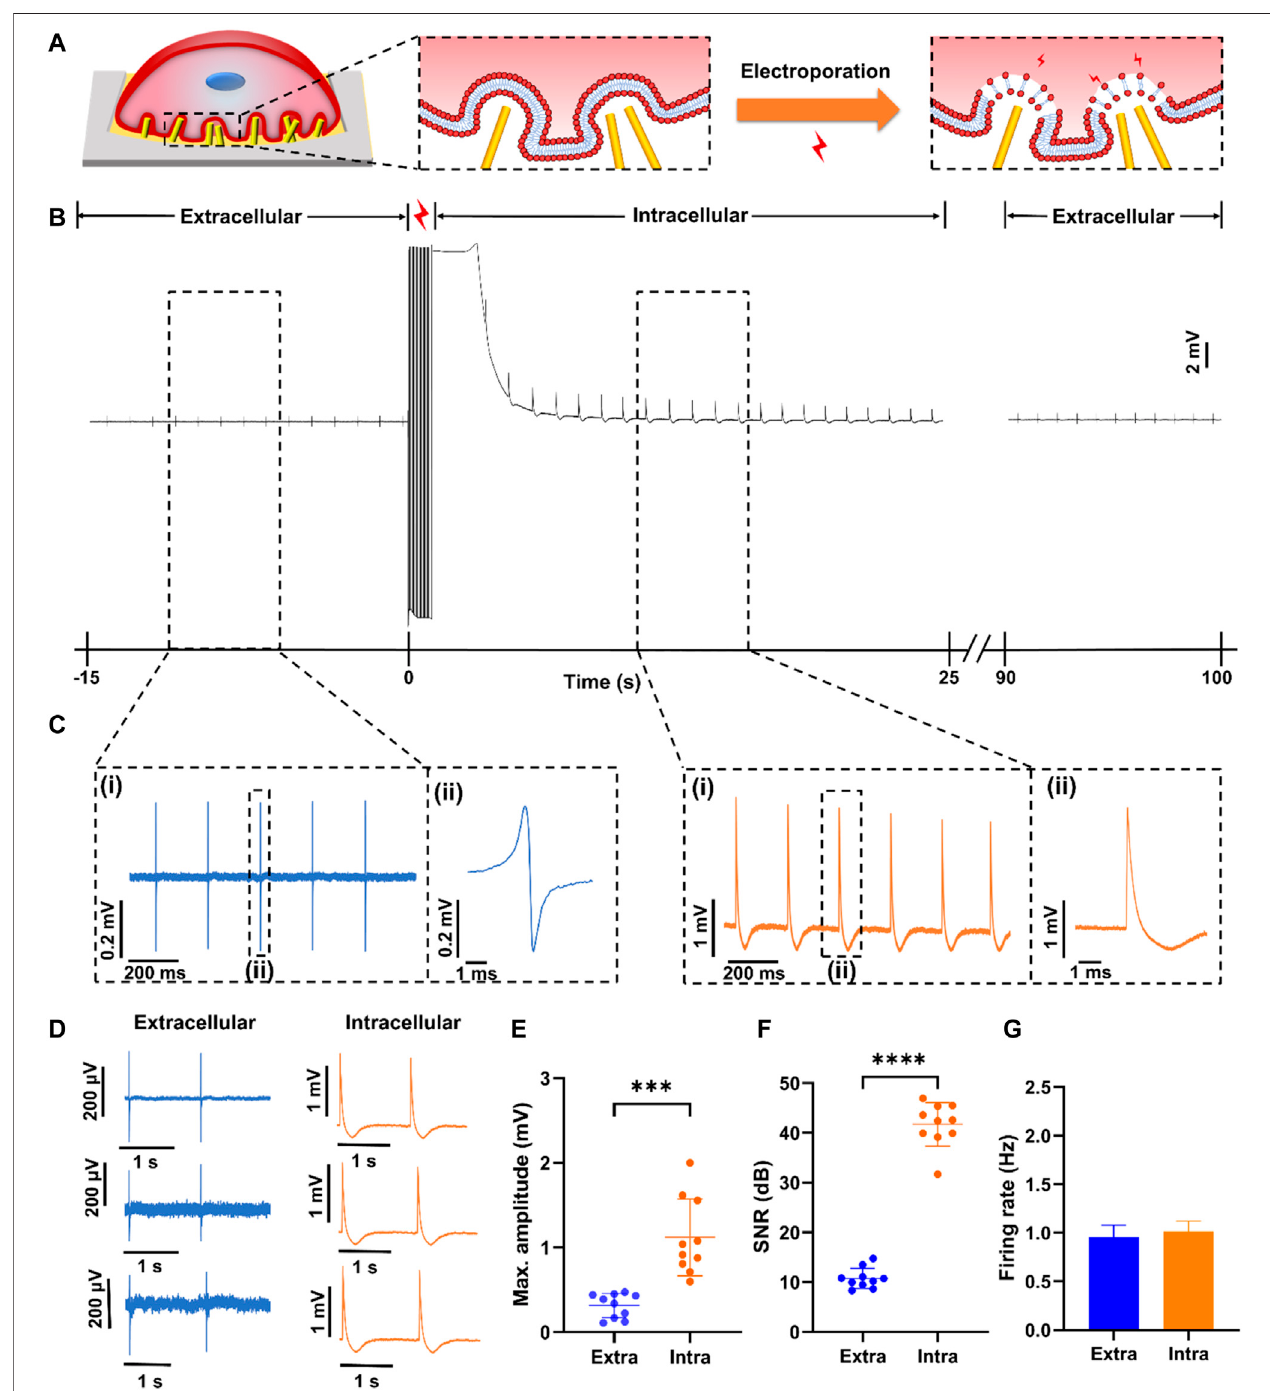
FIGURE 5 | Electrophysiological signals of rat cardiomyocytes recorded by NPMEA. (A) Schematic diagram showing the concept of multi-site electroporation at the three-dimensional ZnO nanopatterned biocompatible interface. (B) Transition from extracellular measurement of cardiomyocytes to intracellular measurement with monophasic pluses (amplitude of 3 V, pulse width of 200 μ s, frequency of 20 Hz, duration of 1 s) (at 0 s). After electroporation, the recorded intracellular potential amplitudedecaysovertime duetosealingoftransientpores inthecellmembrane.Gradually therecordingsignalisrestored totheshapeoftheextracellular signal. (C) Theelectricalsignalsrecordingbeforeandafterelectroporation.(i)Partialenlargedsignalsinblackdashboxof (B) .(ii)Close-upviewofdashedregionin(ii)showinga typical signal. (D) Typical extracellular measurement (left) and intracellular measurement (right) of cardiomyocytes. (E) Plot of max amplitude of top ten intracellular and extracellular spikes. (F) Plot of SNR of top ten intracellular and extracellular spikes. (G) Plot of the fi ring rate of intracellular and extracellular signals.